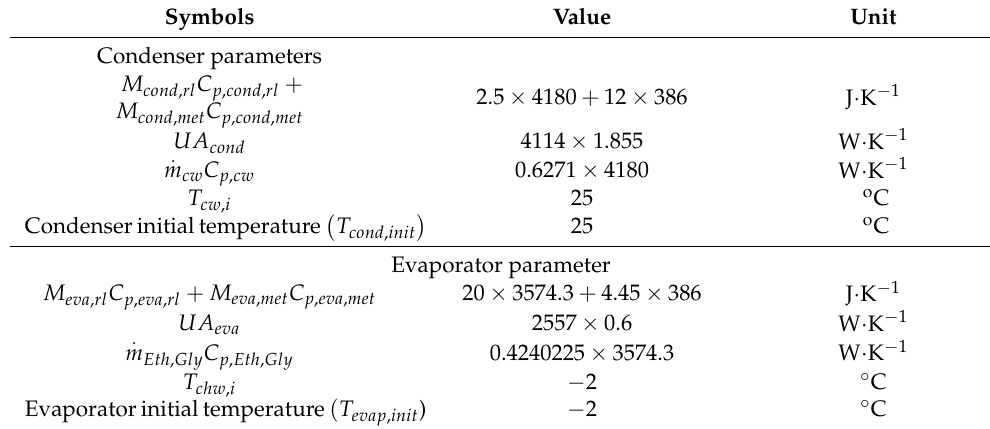
Table 2. The adopted parameters for the condenser and evaporator in the simulations. Symbols Value Unit Condenser parameters M cond , rl C p , cond , rl + 2.5 × 4180 + 12 × 386 J · K − 1 M cond , met C p , cond , met UA cond 4114 × 1.855 W · K − 1 . m cw C p , cw 0.6271 × 4180 W · K − 1 T cw , i 25 o C 25 o